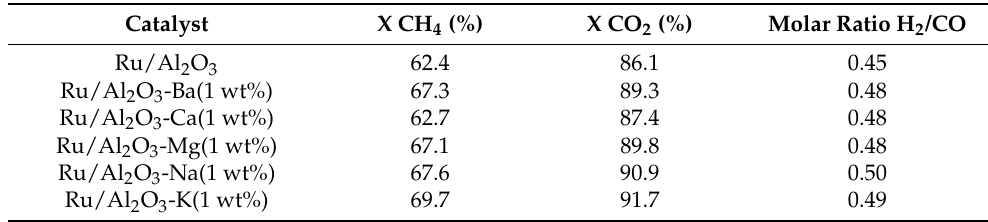
Table 2. % CH 4 conversion, % CO 2 conversion, and H 2 /CO molar ratio for Ru/Al 2 O 3 -A/AE (1 wt%) catalysts (750 ◦ C, 135 min reaction time). Catalyst weight: 200 mg.